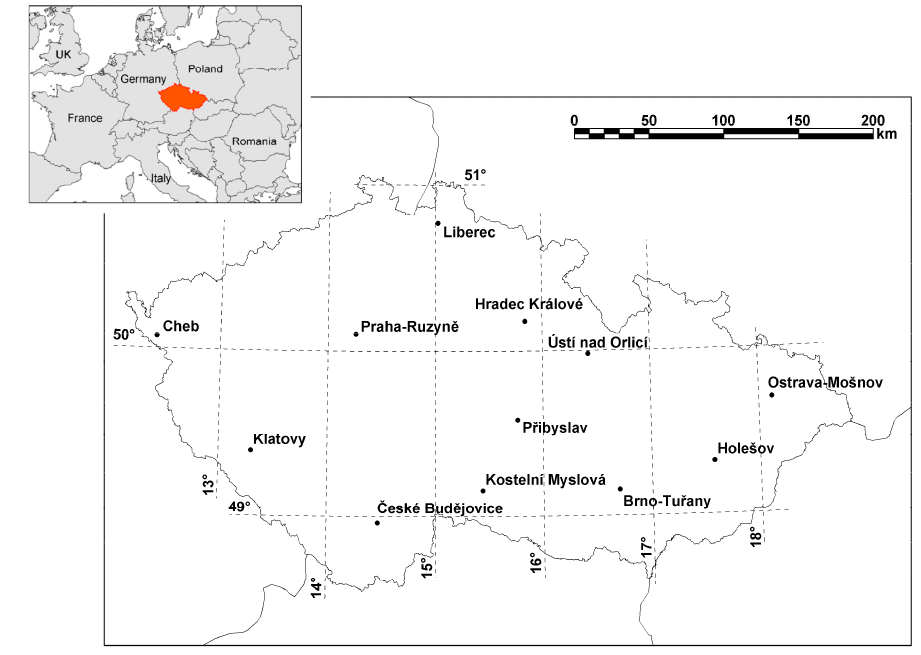
Figure 1. Location of the Czech Republic and meteorological stations used to calculate mean temperature (black dots).